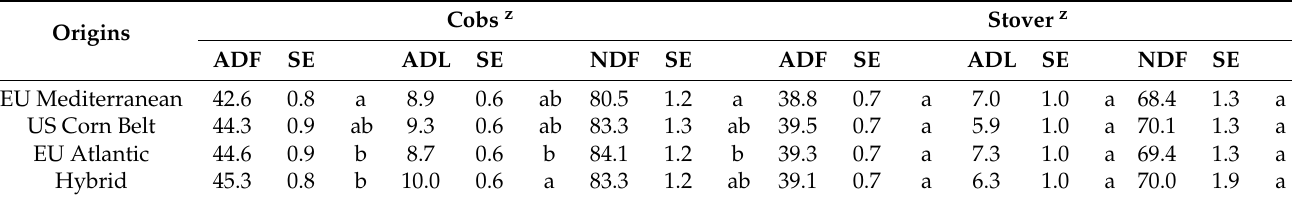
Table 4. Origin means follow by standard error (SE) of fiber components: acid detergent fiber (ADF), acid detergent lignin (ADL), and neutral detergent fiber (NDF) described in Table 2 grown at four environments in Galicia, Spain, in 2010 and 2011. Values ordered based on cob ADF